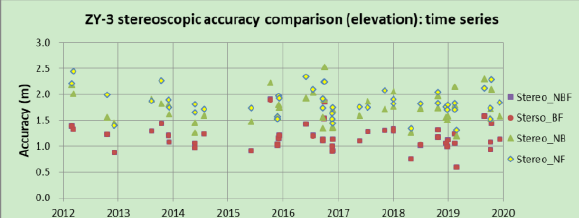
Figure 21. ZY-3 stereoscopic accuracy comparison (elevation) Num=47